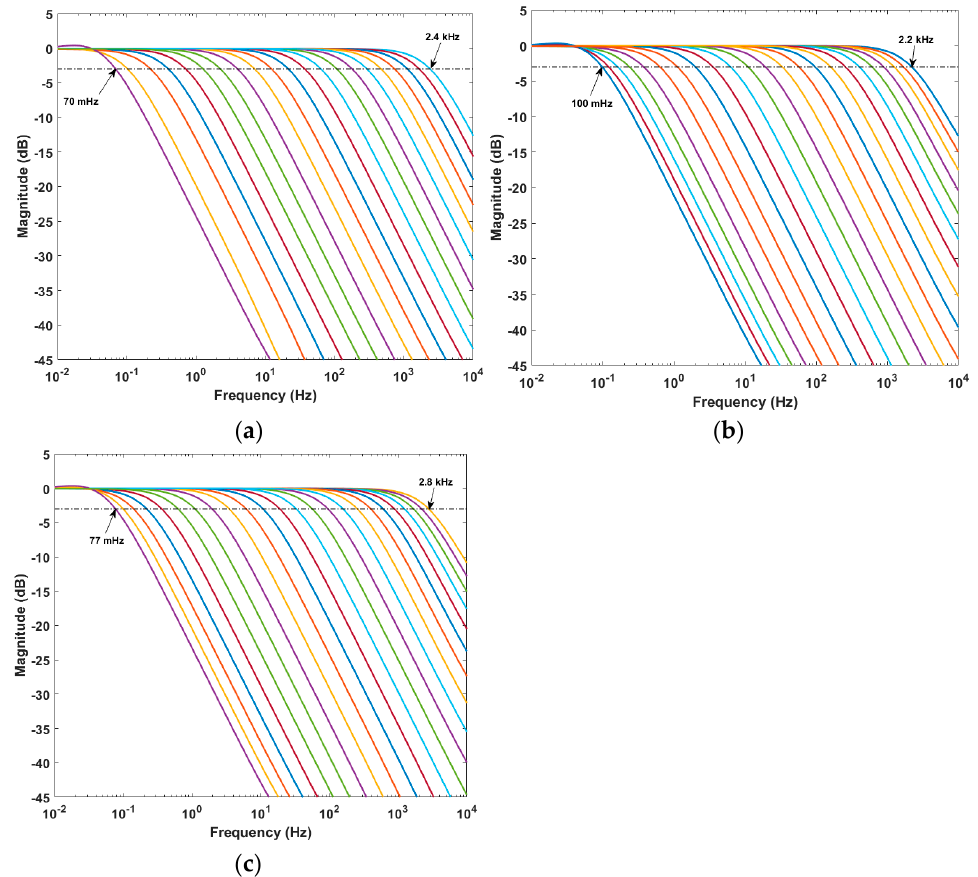
Figure 6. Frequency response vs V gc for 500 nA bias current: ( a ) Filter-1; ( b ) Filter-2; and ( c ) Filter-